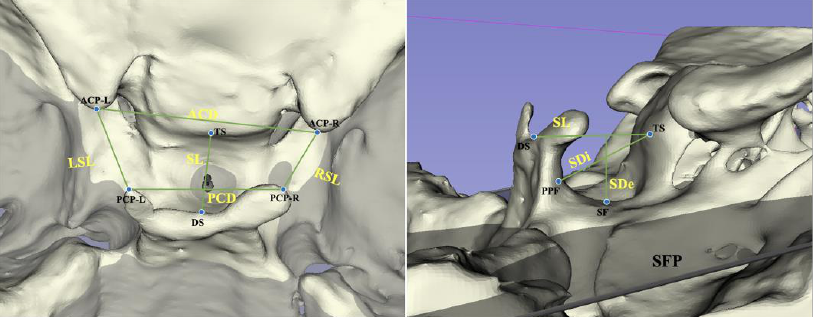
Figure 2. Sella turcica linear dimensions based on CBCT. ACD: anterior clinoid distance; PCD: posterior clinoid distance; LSL: left sella length; RSL: right sella length; SL: sella length; SDe: sella depth; SDi: sella diameter; ACP-R: the apex of the anterior clinoid process on the right side; ACP- L: the apex of the anterior clinoid process on the left side; PCP-R: the apex of the posterior clinoid process on the right side; PCP-L: the apex of the posterior clinoid process on the left side; DS: the dorsum sellae point; TS: tuberculum sellae; PPF: the most posterior point of the posterior wall of the sella turcica; SF: the deepest point of the sella turcica; SFP: sella floor plane.